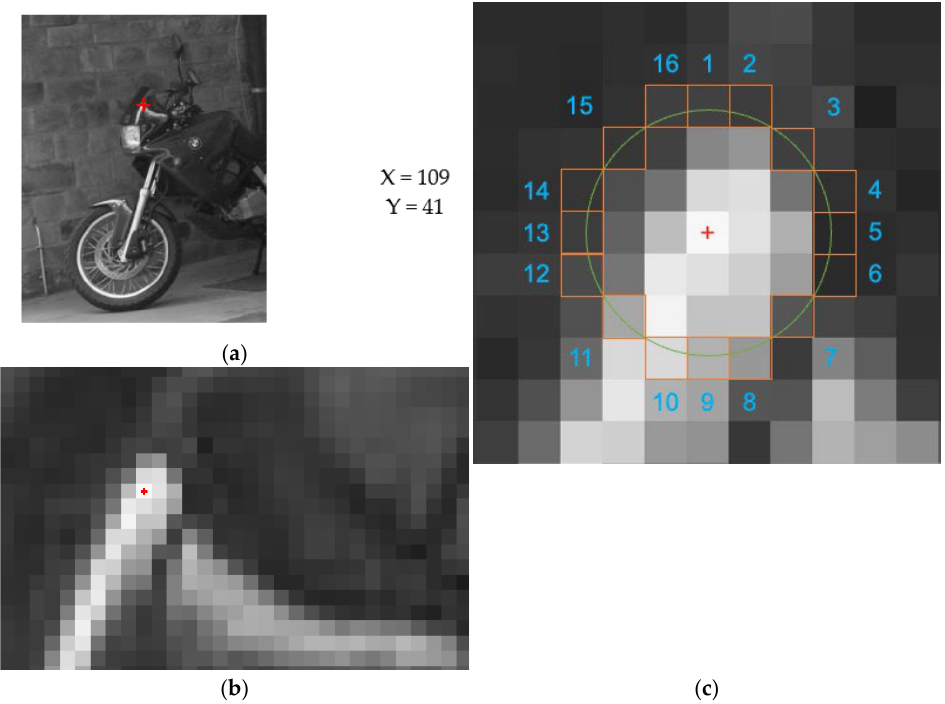
Figure 6. FAST. ( a ) Bike as reference image cropped (Oxford dataset), ( b ) with one corner marked (red). ( c ) Bresenham circle (green) within a 7 × 7 Patch (orange).